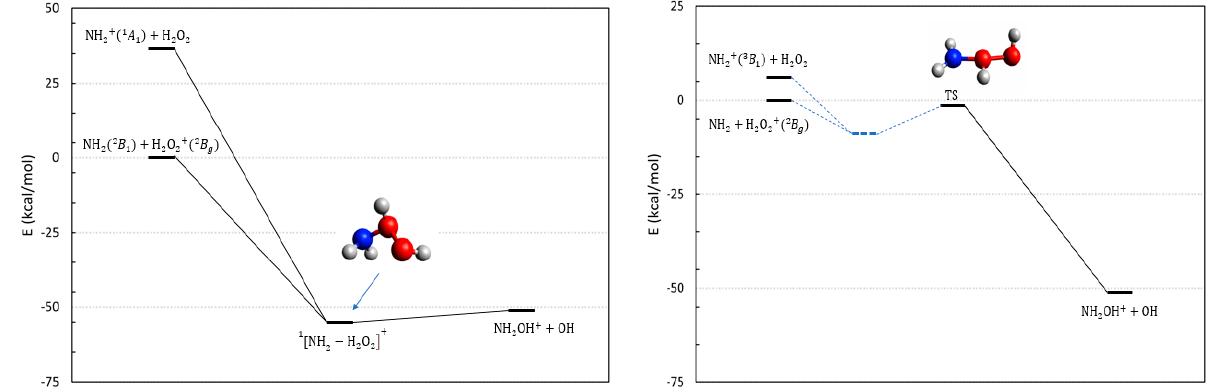
Figure 6. Energetic scheme of the possible entrance and exit channel of reactions 14 – 16 involving the system [NH (cid:2870) − H (cid:2870) O (cid:2870) ] (cid:2878) with singlet ( left ) and triplet ( right ) multiplicity. Energies computed at CCSD(T)/Def2-TZVPP level. The intermediate complex for the singlet case is shown. In the right panel, we have reported the only stationary point that we have been able to locate that corresponds to a transition